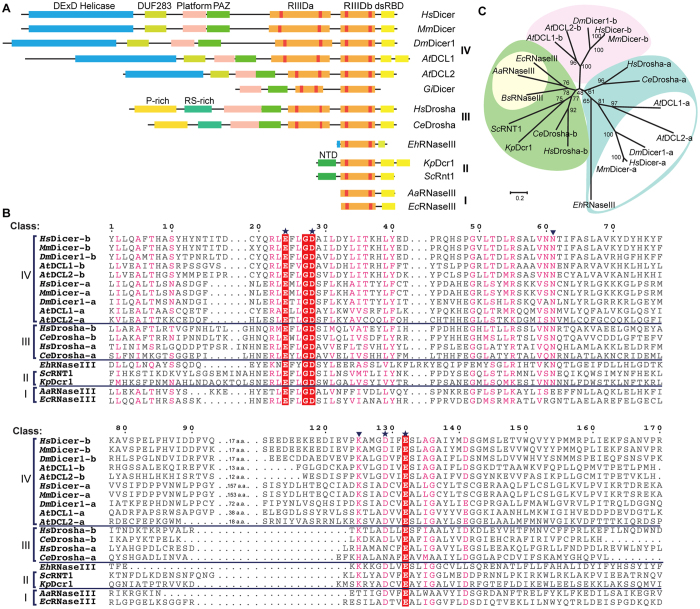
EhRNaseIII is a non-canonical Dicer.(A) Domain architectures of representative RNaseIIIs; tandem RIIID domains of Drosha and Dicer are designated as RIIIDa and RIIIDb, respectively. Hs, Homo sapiens; Mm, Mus musculus; Dm, Drosophila melanogaster; At, Arabidopsis thaliana; Gi, Giardia intestinalis; Ce, Caenorhabditis elegans; Sc, Saccharomyces cerevisiae; Kp, Kluyveromyces polysporus; Eh, Entamoeba histolytica; Aa, Aquifex aeolicus; Ec, Escherichia coli. (B) Sequence alignment of RIIID domains from each class of RNase III enzyme. HsDicer1, GI: 152012889; HsDrosha, GI: 20139357; MmDicer, GI: 257051057; DmDicer1, GI: 7300916; AtDCL1, GI: 34922211; AtDCL2, GI: 332640405; CeDrosha, GI: 20141625; ScRNT1, GI: 618855177; KpDcr1, GI: 342351115; EhRNaseIII, GI: 56467134; AaRNaseIII, GI: 160877684; EcRNaseIII, GI: 485668531. Conserved catalytic residues are indicated by asterisks, newly identified catalytic residues are labeled with an inverted triangle. (C) Maximum-likelihood tree of RIIID domains from RNaseIII families. RIIIDa and RIIIDb domains of class IV RNaseIIIs are colored white and pink, respectively. RIIIDa and RIIIDb domains of class III RNaseIIIs are colored cyan and green, respectively. Class II RNaseIIIs are also colored green. Class I RNaseIIIs are colored orange. Bs, Bacillus subtilis.